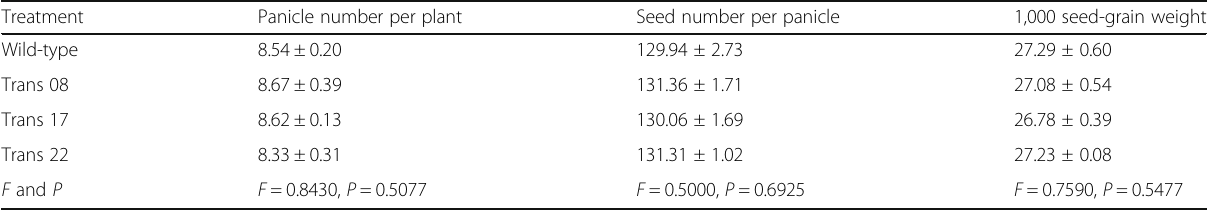
Table 3 Values of yield-associated components collected from populations of the homozygous transgenic lines